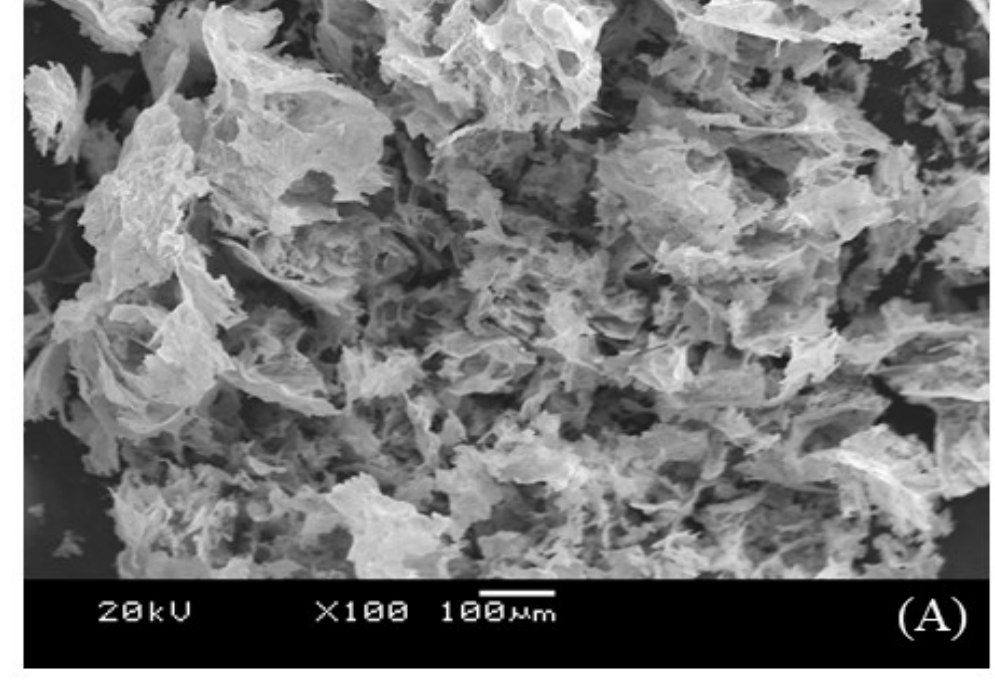
Figure 7. Long time-on-stream for perovskite catalyst calcined at 725 ° C, using 0.05 g of catalyst with GHSV of 84 L/g/h; T = 700